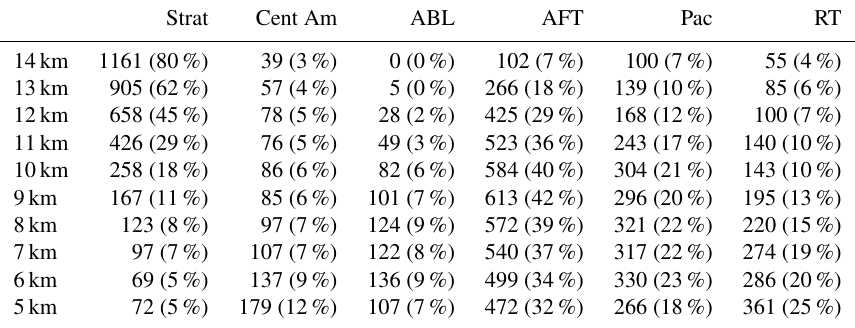
Figure 8. Examples of HYSPLIT 12-day backward trajectories arriving at TMF at 7km altitude for four selected seasons and categories (see text for details). Table 4. Number of air parcels ending at TMF during lidar measurements over the period 2000–2015, classified as “stratosphere”, “Central America”, “ABL” (Asian boundary layer), “AFT” (Asian free troposphere), “Pacific Ocean” and “RT” (residual trajectories) (see text for